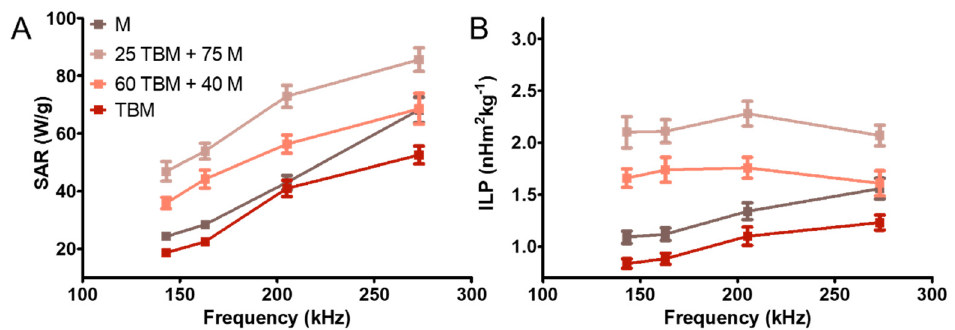
Figure 4. Frequency dependence of SAR ( A ) and ILP ( B ) for the different nanoparticles suspension. Magnetic field strength: 12.5 kA/m; particle concentration: 30 mg/mL.